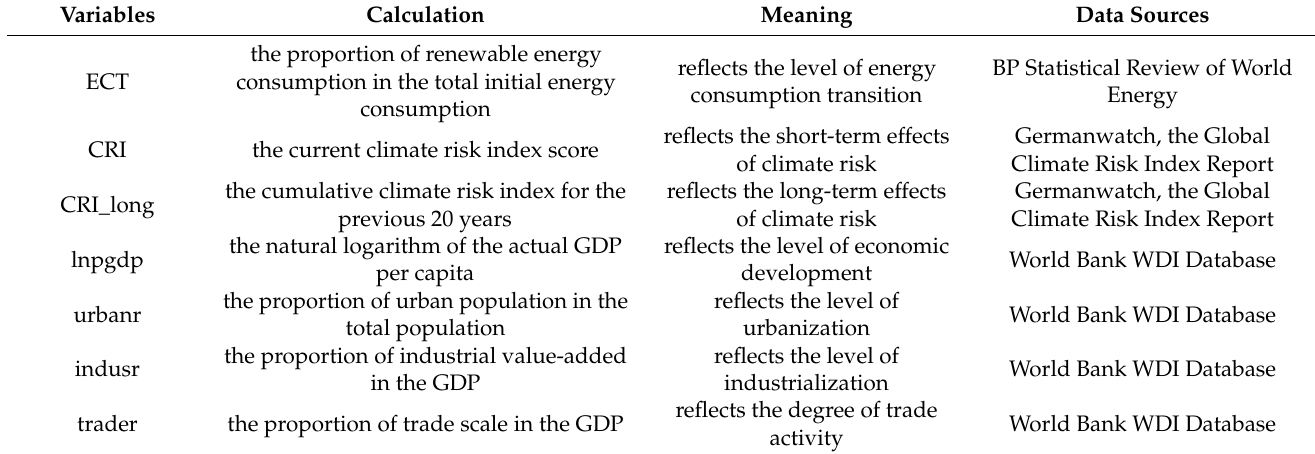
Table 1. Variables and Data